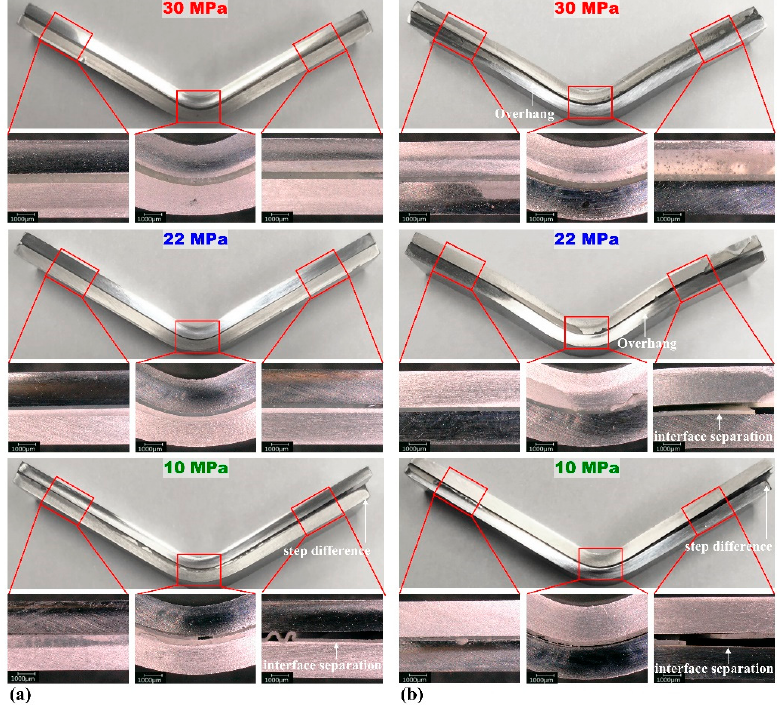
Figure 12. DP590–A5052 multi-material after the flexure test: ( a ) steel (upper)–aluminum (lower) and ( b ) steel (lower)–aluminum (upper). The white arrow indicates interface separation or step difference.